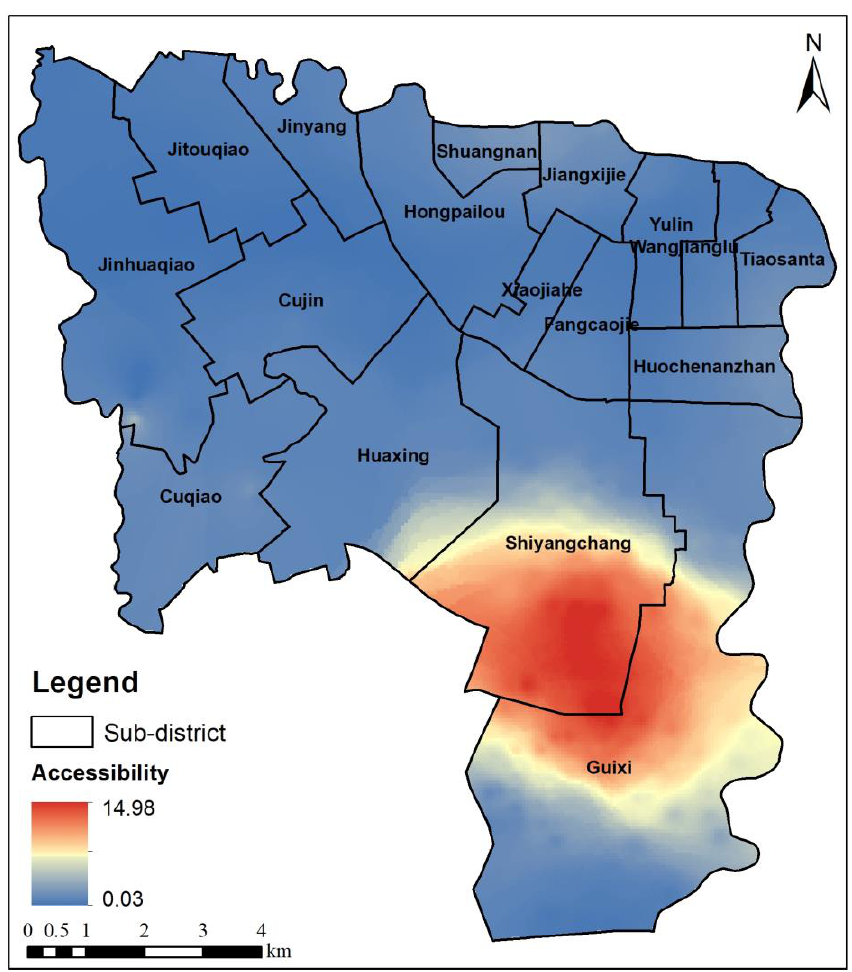
Figure 7. Park spatial accessibility based on Euclidean distance G2SFCA method.